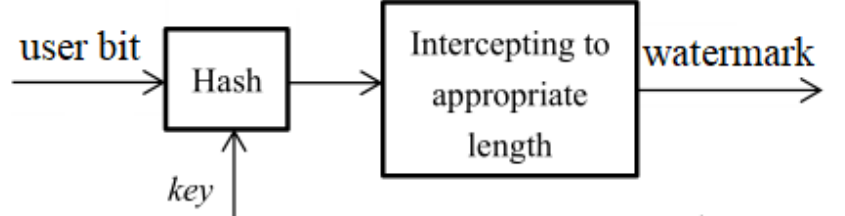
Figure 2. Basic watermark generation scheme.